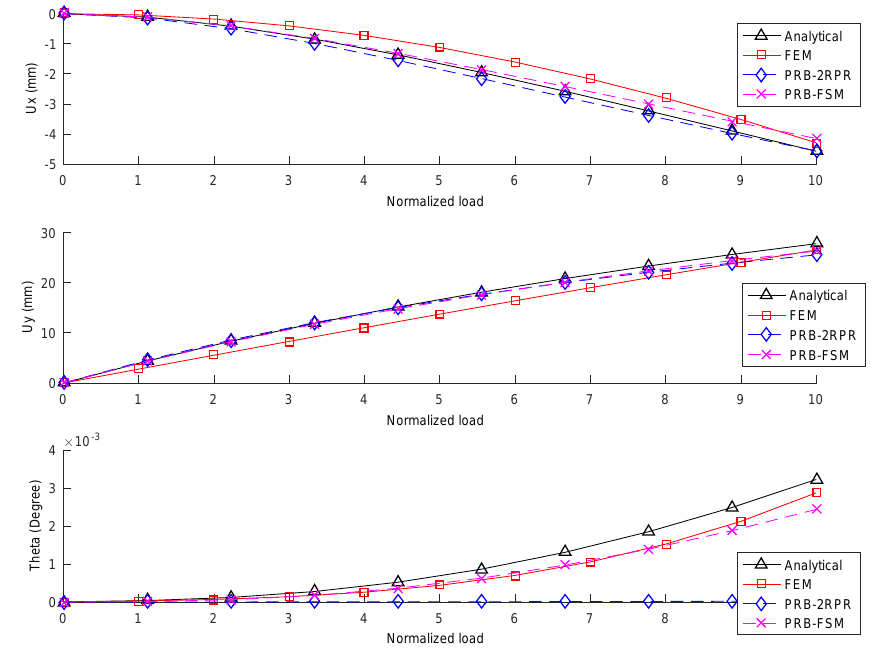
Figure 10. Comparison of the software results with analytical model (BCM) and ABAQUS software. Magnitudes of f x , f y and m x are equal at each step and they are simultaneously incremented between zero and ten.